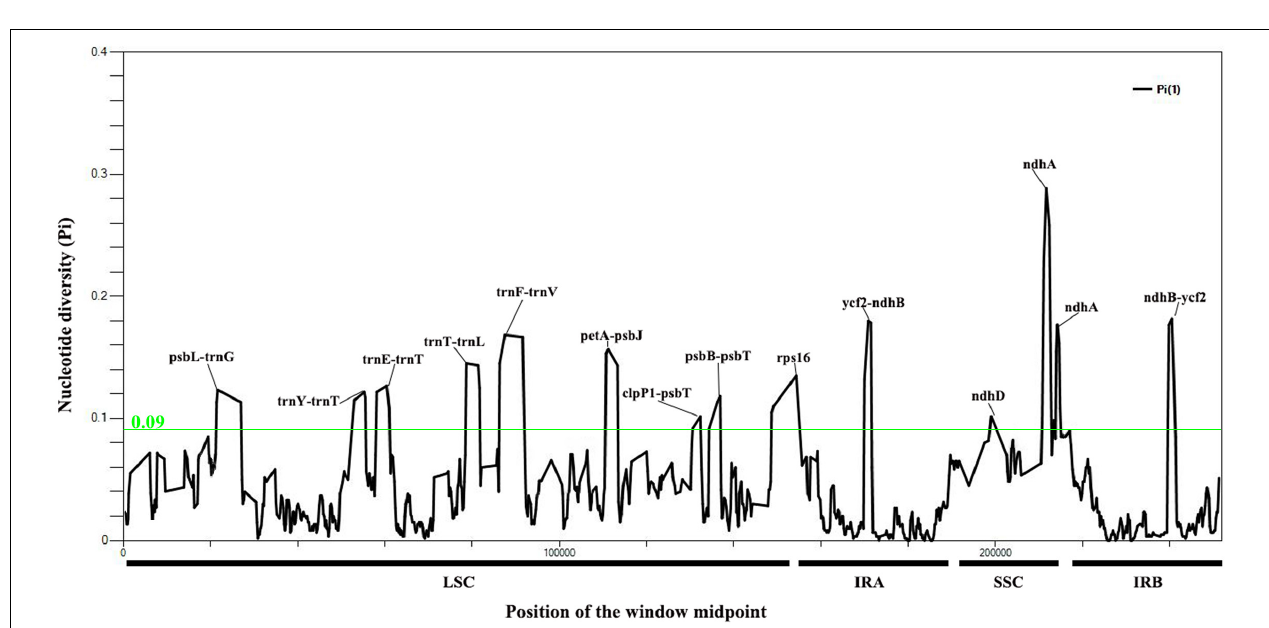
FIGURE 2 | Analyses of expansion and contraction of inverted repeats in the seven Cypripedium chloroplast genomes.